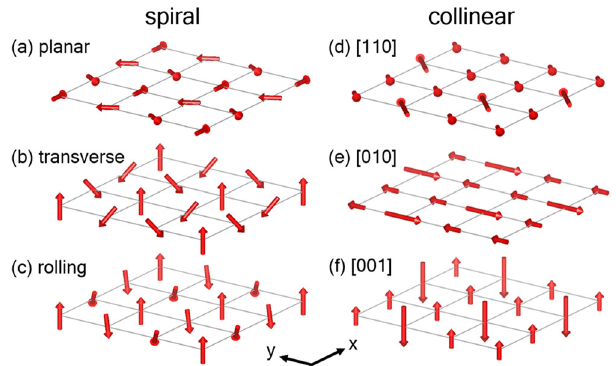
Fig. 2 Lowest energy magnetic structures q ¼ ð 1 ; 1 ; 0 Þ 2 π basal plane in Sr 2 RuO 4 . The a – c structures represent different types of spiral magnetic order and d – f corresponds to the collinear up-up- down magnetic order with different moment directions